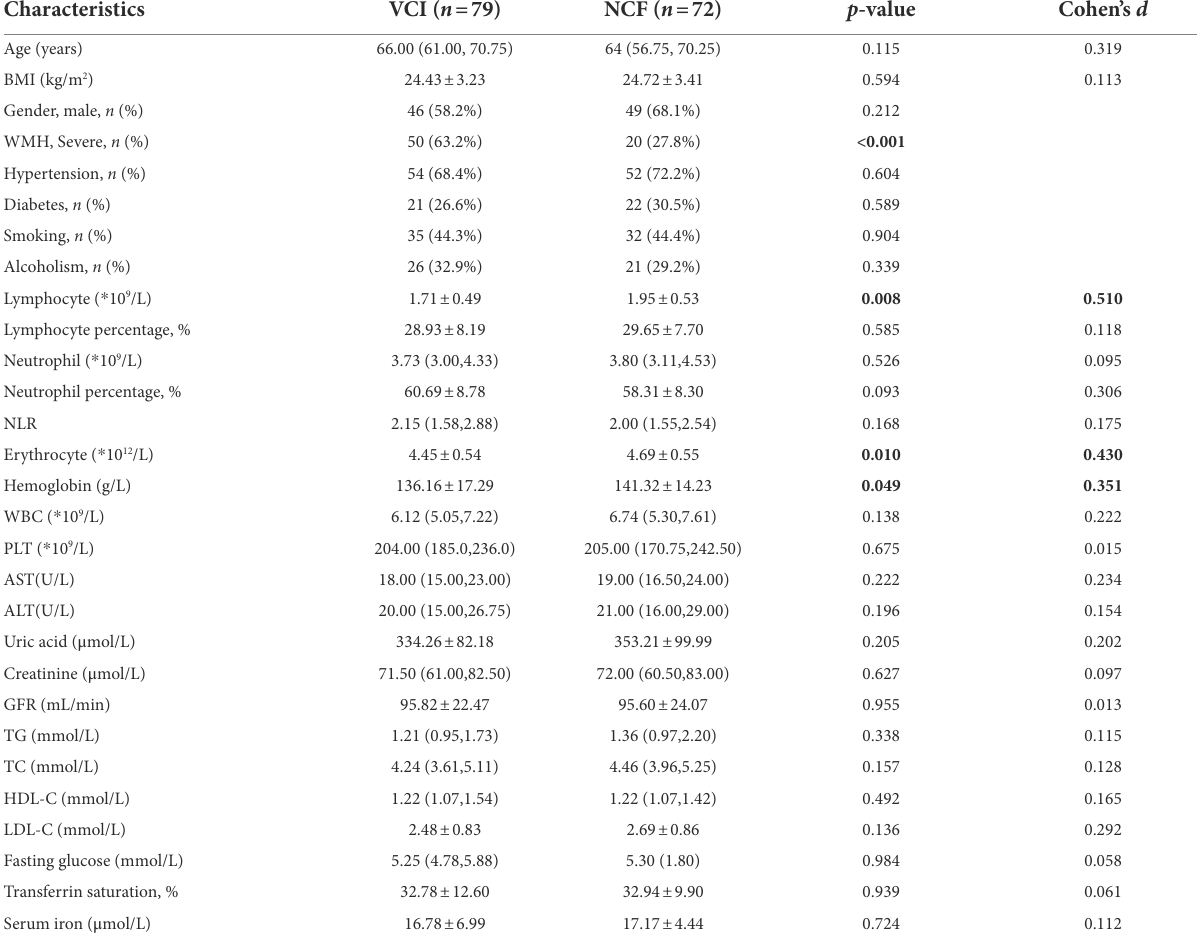
TABLE 1 Comparison of variables between the VCI and NCF groups.